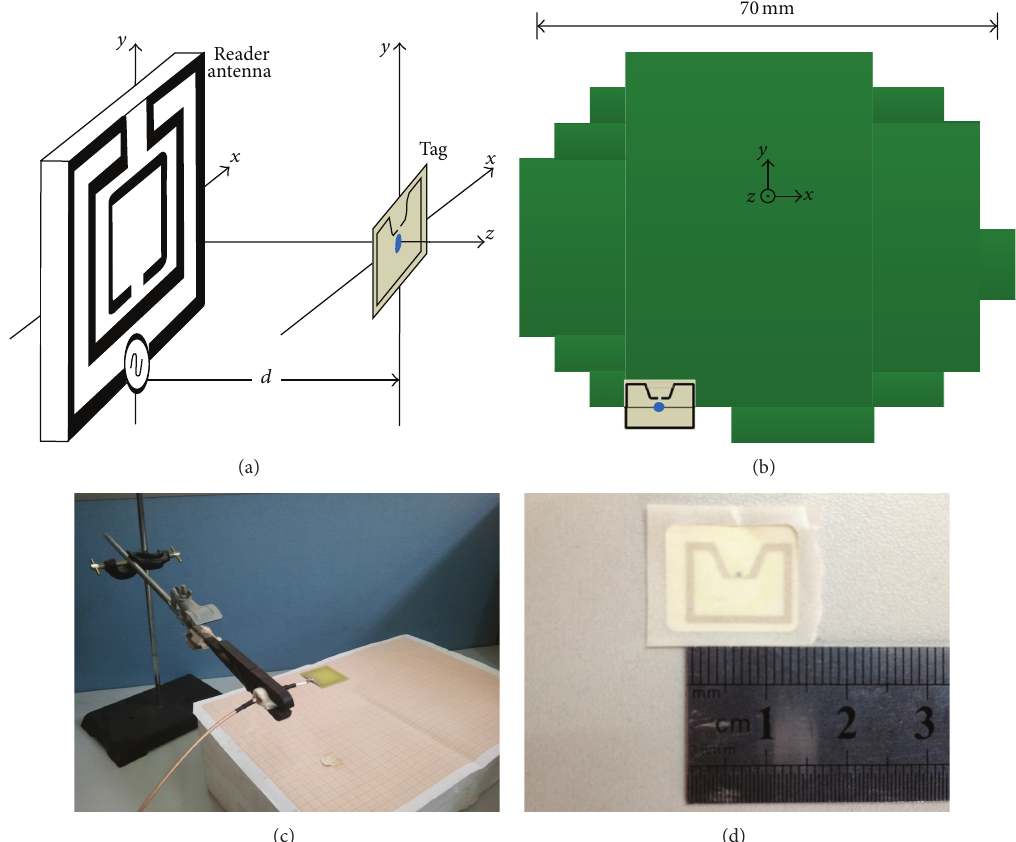
Figure 7: Near-field measurement. (a) Schematic view. (b) Read width at 𝑥𝑦 -plane and 𝑧 = 10 mm. (c) Test scene. (d) Impinj UHF button.